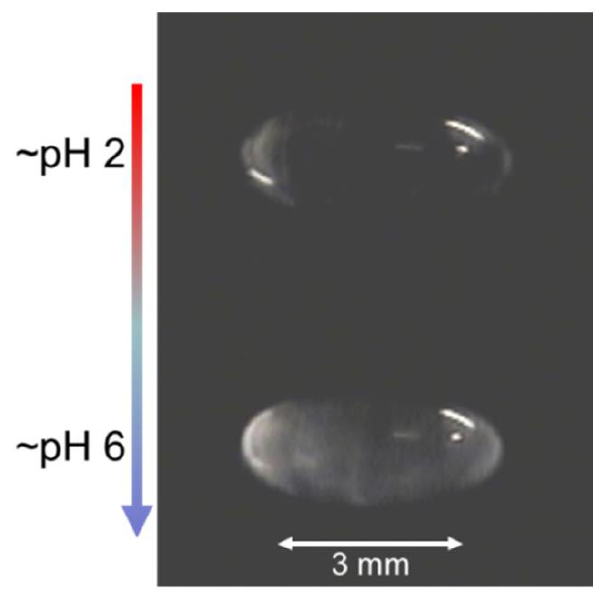
Figure 23. A drop of hydroxyapatite dissolved in phosphoric acid (H 3 PO 4 ). The solution was acidic ~pH 2 when it was introduced. Ammonia was wafted over the sample to increase its pH to ~6. The change in pH resulted in precipitation of crystals in the solution. The cloudy appearance of the drop in the lower part of the image is due to the presence of a finely divided precipitate.